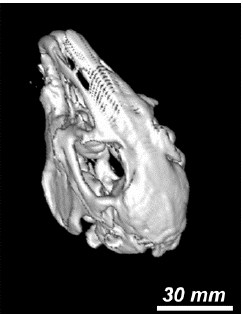
Figure 5. 3D computed tomography (CT) reconstruction image of the animal model before surgery. Scale was estimated based on corresponding 2 ‐ D image.